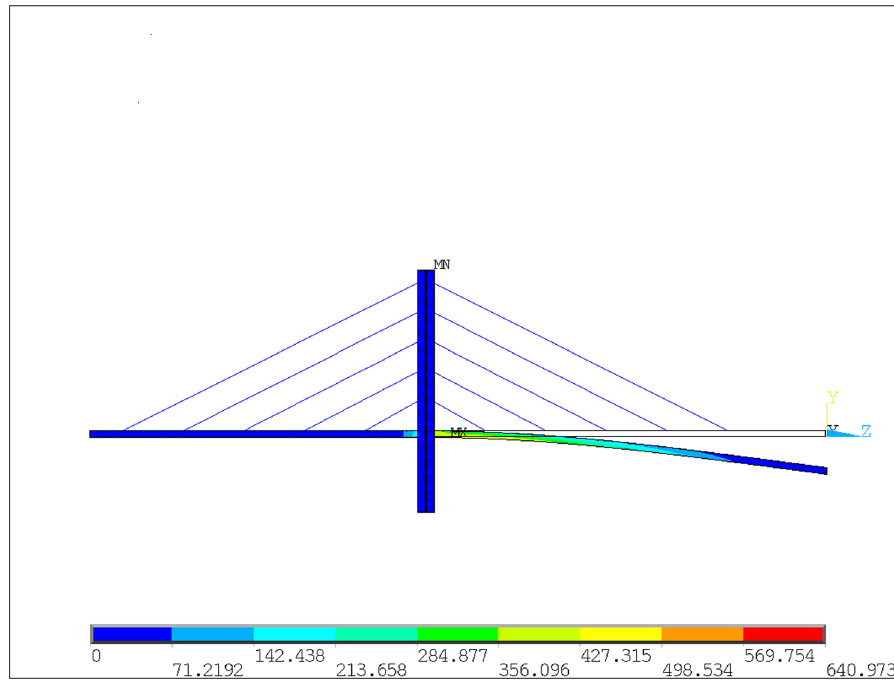
Figure 9: Stress of numerical model Harp type